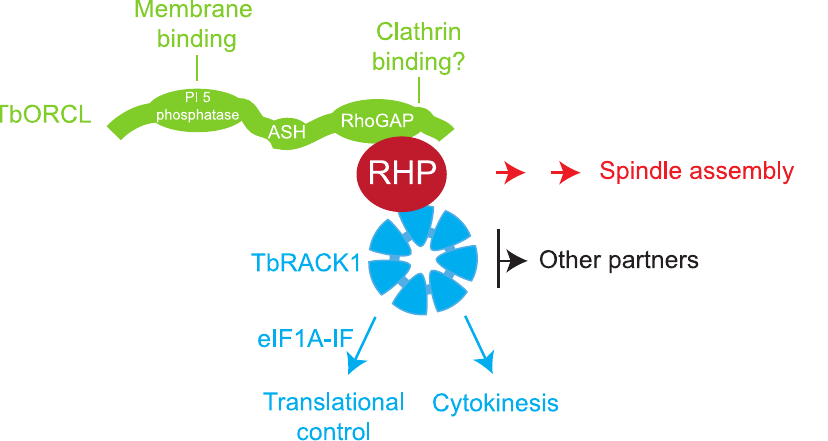
Figure 10. Model for TbRHP interactions and downstream functions. TbRHP and its two interacting partners are shown, TbOCRL as a series of green lozenges to indicate the multidomain structure of the protein and TbRACK as a seven-bladed structure reflecting the WD40 fold. Interactions between these factors are shown. Those interactions or functions that have been demonstrated in T. brucei are highlighted in red, while interactions inferred by homology with mammalian systems are shown in gray. The multiple interactions attributed to RACK1 in mammalian cells are shown as ‘Other partners’ for simplicity. Figure S1 Alignment of TbRHP with representative Rho protein sequences. Predicted protein sequences were retrieved from the non-redundant database using BLASTp. Orthology was verified by reverse BLAST against the T. brucei genome sequence and selected sequences were aligned using ClustalX and default parameters. ‘‘-’’ represents gaps introduced into the alignment for optimization. Colorization indicates identity, conservative and semiconservative substitutions on a five point scale from red (conserved in 80% or more sequences), through light red, blue, light blue and white (no conservation). (TIF) Figure S2 Characterization of anti-TbRHP antiserum and turnover of TbRHP. (A) Western analysis of whole cell lysates prepared from BSF and PCF trypanosomes (B and P respectively); Whole cell lysates from 10 7 cells were fractionated by